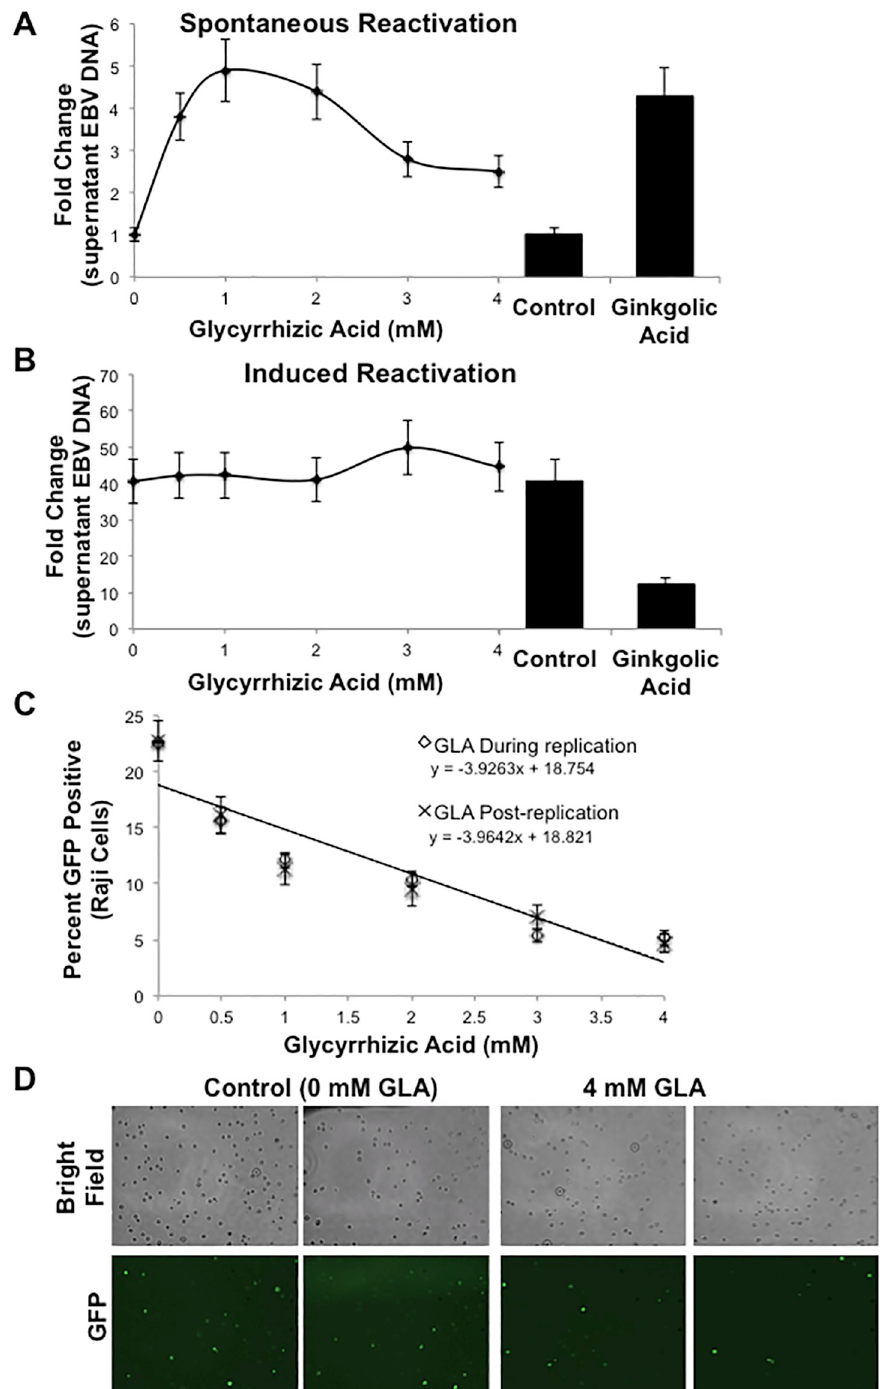
Fig 5. Glycyrrhizic acid treatment targets the maintenance of EBV latency. A) HEK 293 EBV BAC cells were treated with DMSO, ginkgolic acid, or graduated amounts of glycyrrhizic acid. Supernatant fluids were collected 72 hours post-treatment, DNase-resistant encapsidated virion associated DNA harvested, and real time PCR performed to quantitate EBV DNA levels and the spontaneous reactivation of the virus. Results are shown as the means ± the standard deviation of experiments performed in triplicate. B) HEK 293 EBV BAC cells were transfected with a ZTA- expression construct for the induced reactivation of EBV/ 24 hours post-transfection, cells were treated with DMSO, ginkgolic acid, or graduated amounts of glycyrrhizic acid. Supernatant fluids were collected 72 hours post-transfection,